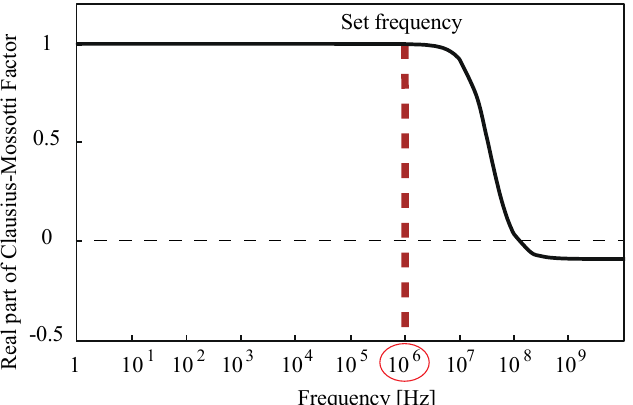
Figure 4. Calculated values of the Clasius-Mossotti equation using the parameters in Table 1: the frequency of 1 MHz was determined as high as possible in the range of positive dielectrophoresis to suppress electrolysis of the electrode from this.